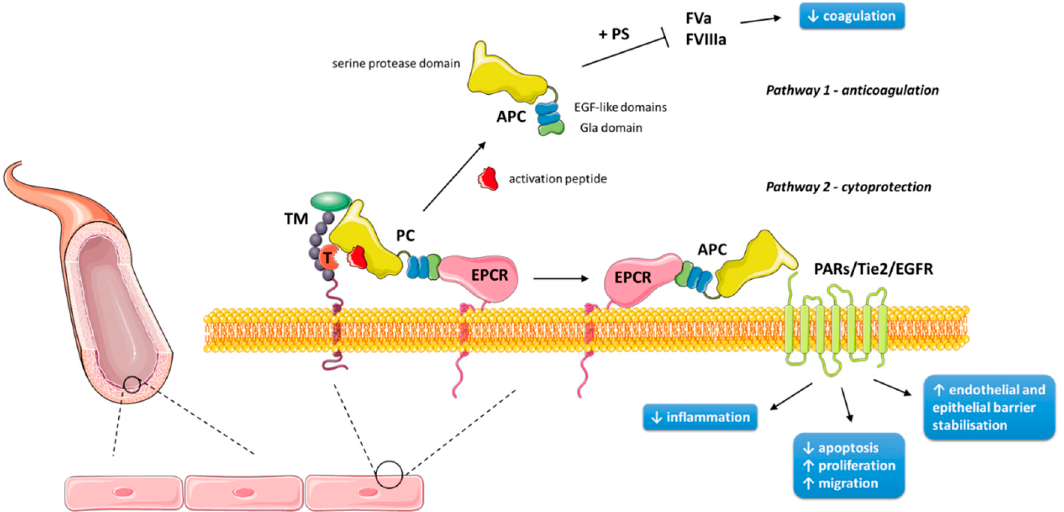
Figure 1. Mechanism of protein C activation and actions on the surface of human endothelial cells. Protein C (PC) is bound to an endothelial protein C receptor (EPCR) on the surface of endothelial cells, where it is activated by thrombin (complexed with thrombomodulin) cleavage of its activation peptide. Activated protein C (APC) is then either released, where it participates in negative feedback of the coagulation cascade (pathway 1), or presented to cleave PARs/Tie2/EGFR in order to exert its cytoprotective effects (pathway 2). Pathway 2 also occurs on the surface of keratinocytes. EGFR: endothelial growth factor receptor; FVa: activated factor V; FVIIIa: activated factor VIII; PAR: protease-activated receptor; PS: protein S; T: thrombin; TM: thrombomodulin. Figure was produced using Servier Medical Art (https://smart.servier.com).